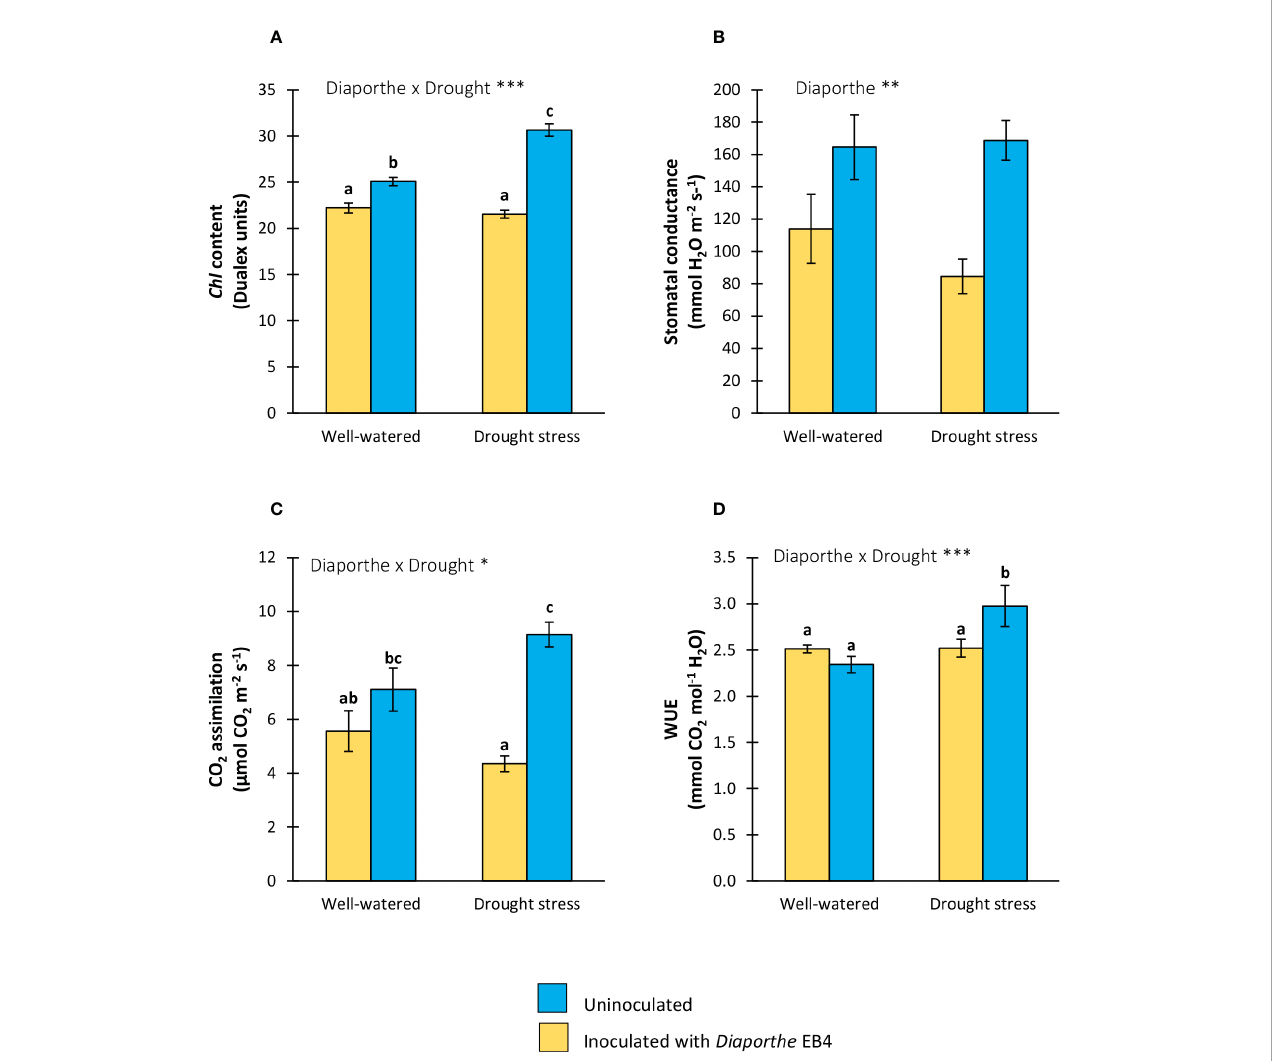
FIGURE 2 (A) Chlorophyll content, (B) stomatal conductance, (C) CO 2 assimilation rate, and (D) water use ef fi ciency (WUE), of tomato plants uninoculated (yellow) or inoculated with Diaporthe EB4 (blue), with two different water treatments (well-watered or drought stress). Different letters indicate different means (Tukey p < 0.05) for the [ Diaporthe inoculation × Drought] interaction. Values are means +SE (n=5). Level of signi fi cance:* p <0.05; ** p <0.01; *** p